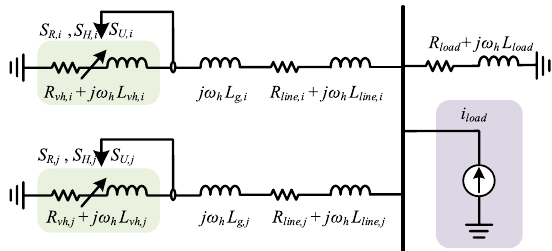
Fig. 14 Equivalent circuit of a microgrid under negative sequence or harmonic